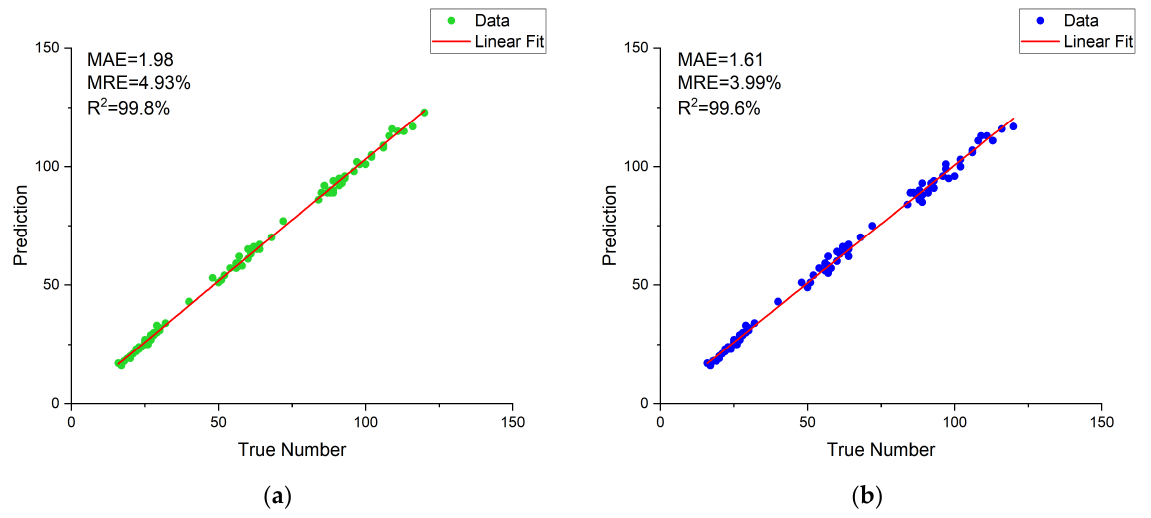
Figure 8. Analysis of pod counting results. ( a ) Correlation analysis between count results of common counting method and true value, ( b ) Correlation analysis between count results of improved counting method and true value.